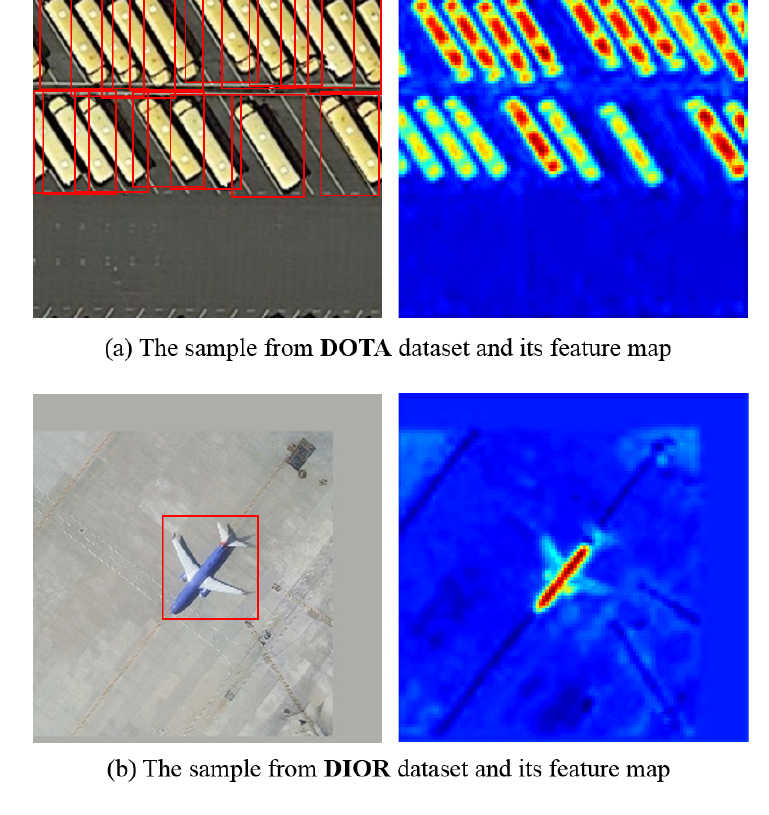
Figure 5. The samples from DOTA and DIOR datasets and their feature